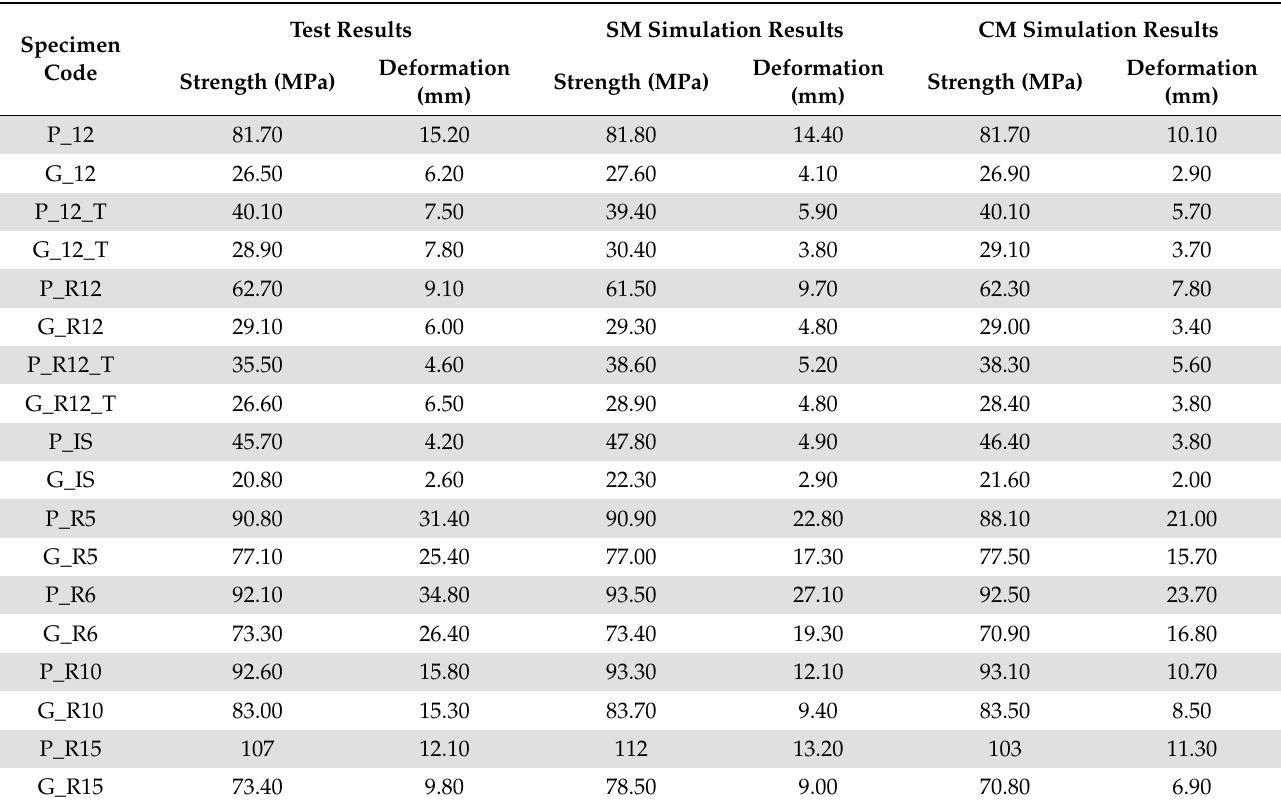
Table 2. Comparison between results of the tests and simulation, for 3D printed specimens, bend- ing stressed.